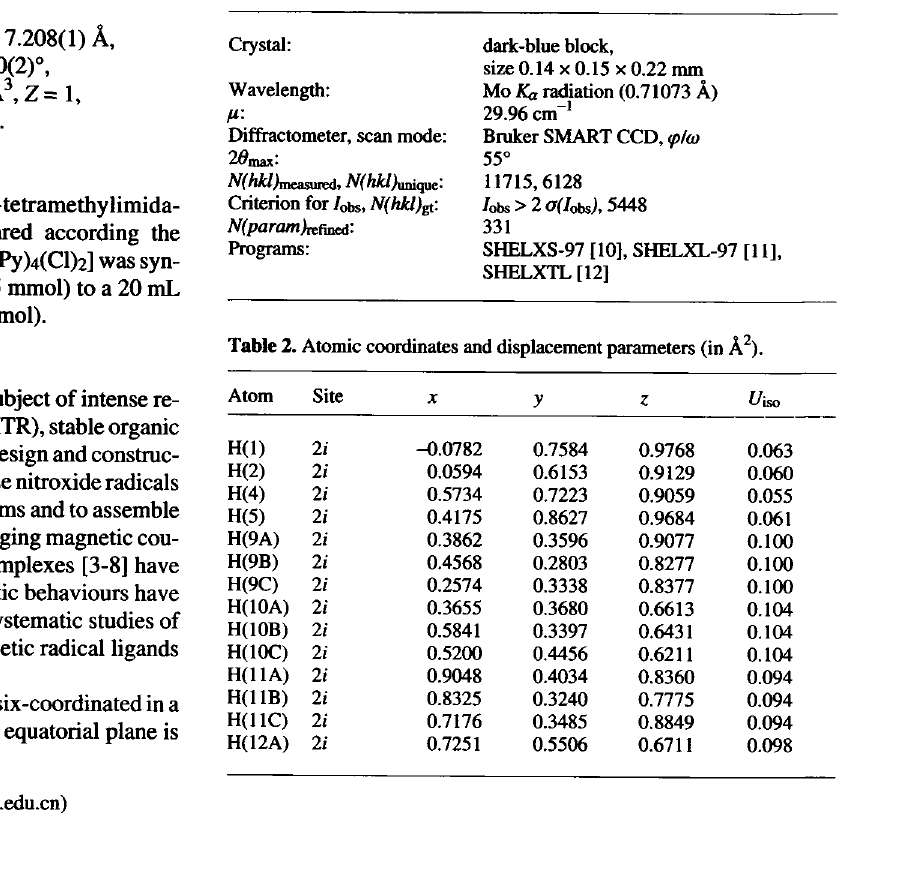
Table 1. Data collection and handling.